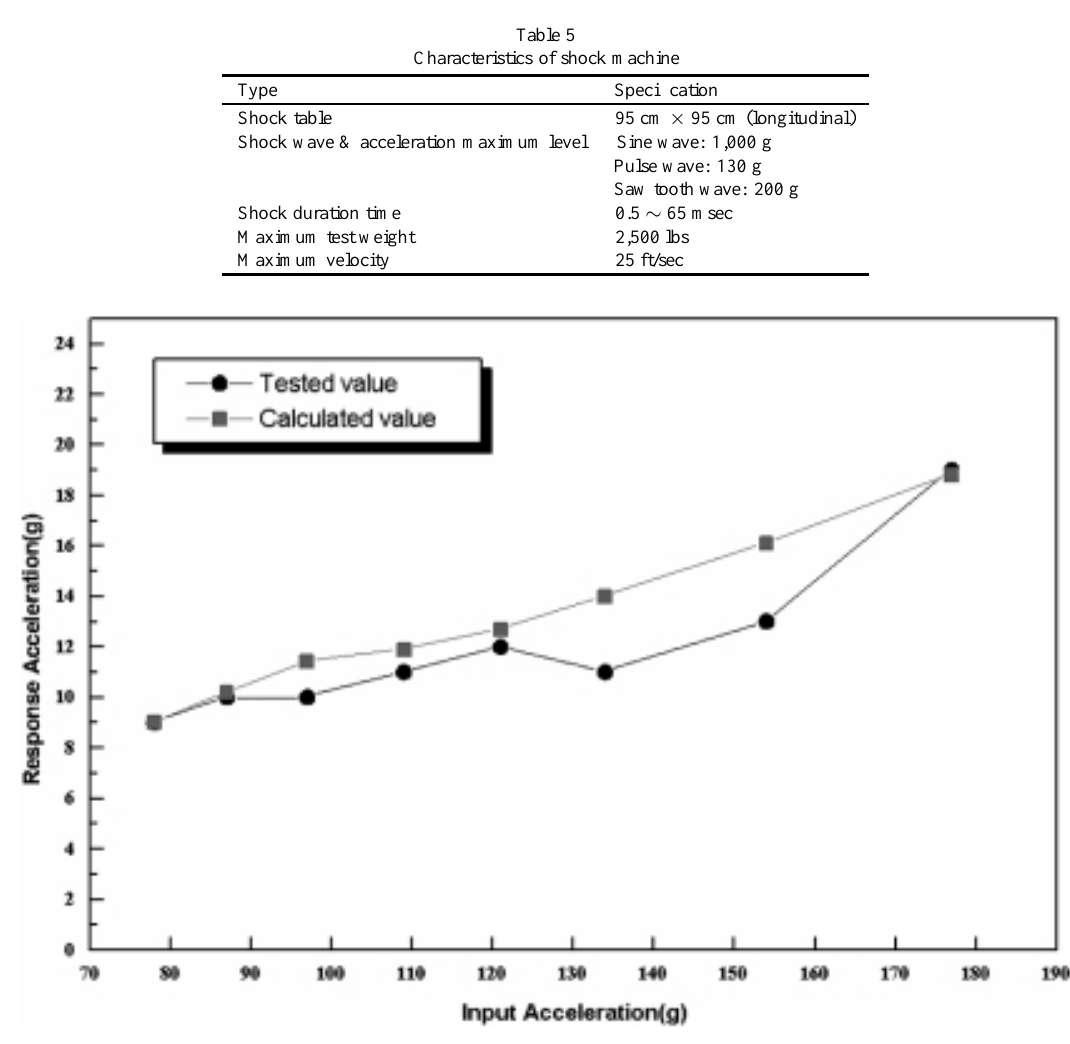
Fig. 4. Comparison of estimated and tested